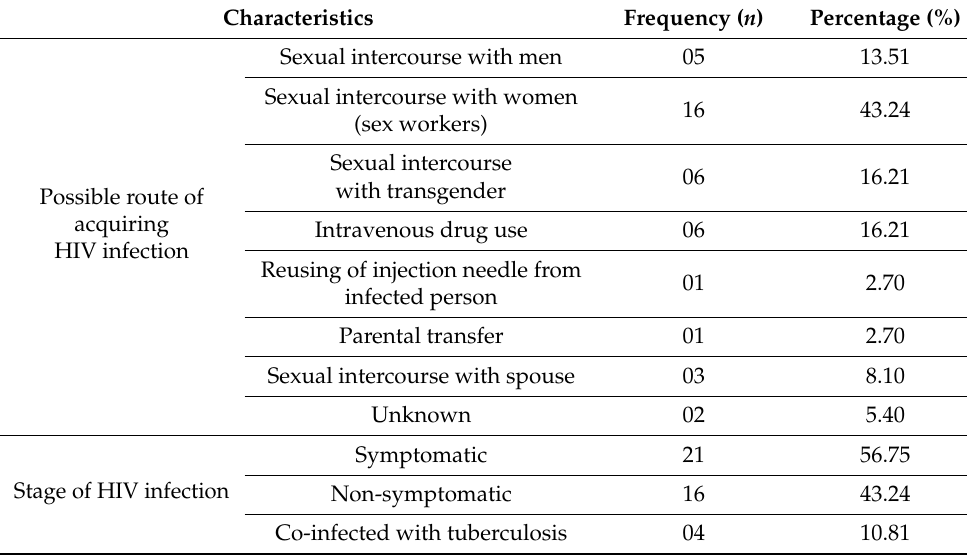
Table 3. The clinical history of studied HIV patients ( n = 37).